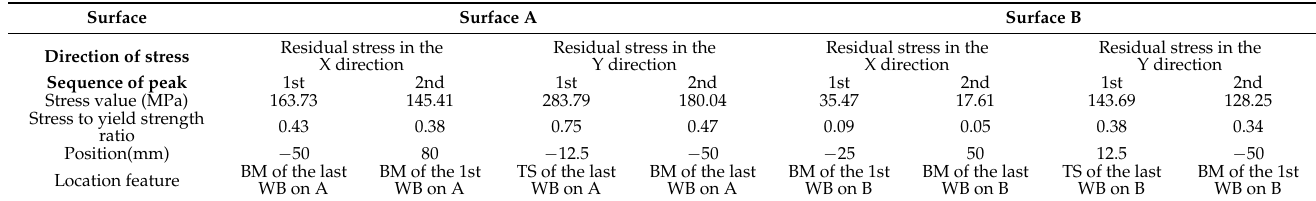
Table 7. Statistical information of peak residual tensile stress near the weld